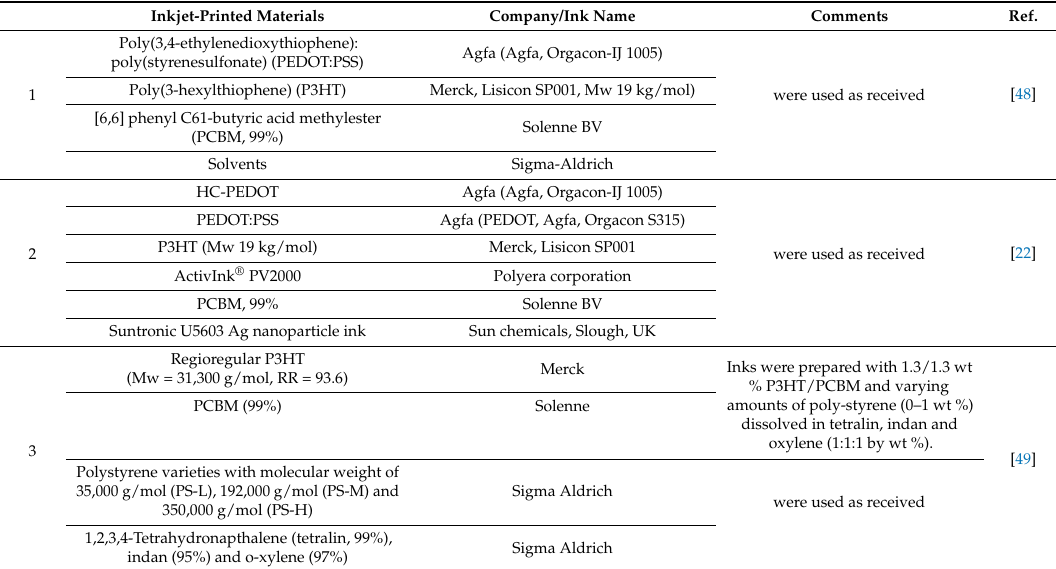
Table 2. Available inkjet printed materials and